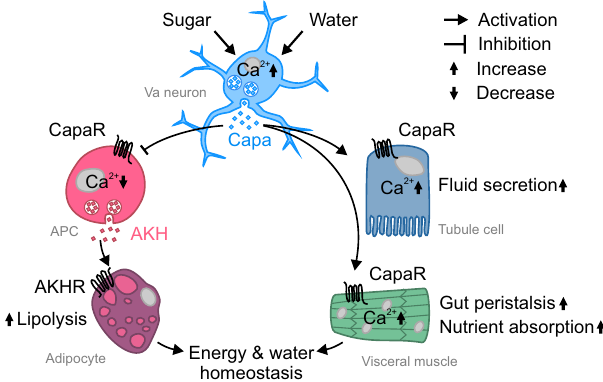
Fig. 9 Model for the systemic actions of Capa/CapaR signaling in mediating nutritional and osmotic homeostasis in adult Drosophila . Capa + Va neurons respond to internal sugar and osmotic cues by activating two separate pathways: one stimulating renal and intestinal activities to promote fl uid secretion, gut contractions and nutrient absorption, and another to restrict glucagon-like AKH release from the APCs and subsequent lipolytic activity in adipose tissue. The Capa circuit thus couple internal cues related to sugar and water abundance to homeostatically regulate energy and water